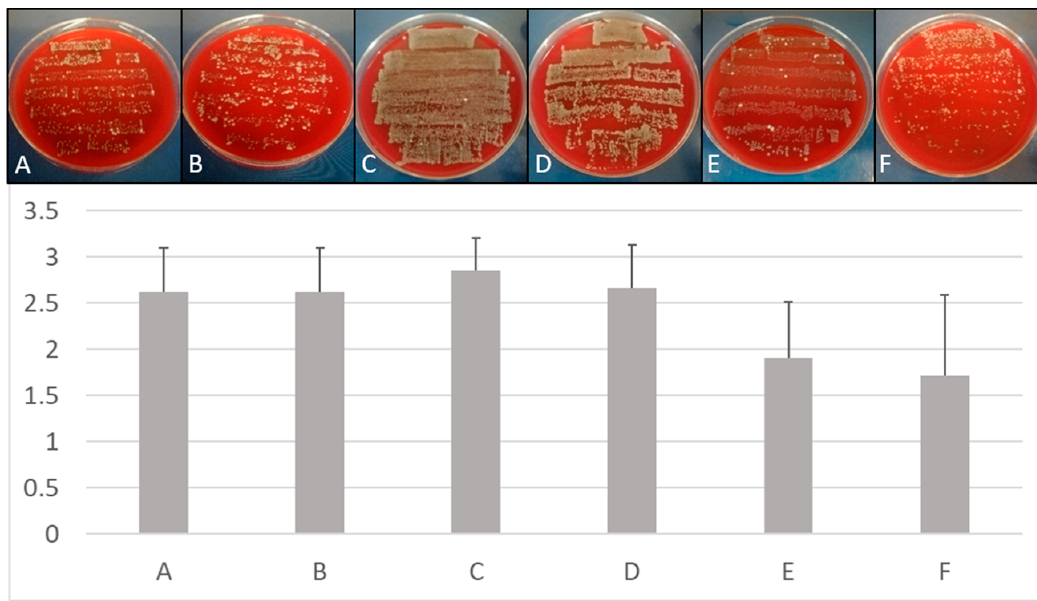
Figure 8. Treatment of multi-species biofilms. Upper panel: Comparison of growth on Columbia Blood Agar plates after different treatment of implants placed in bovine cadaver bone. Lower panel: Quantitative comparison of growth on implants inserted in ribs depending on treatment protocols.